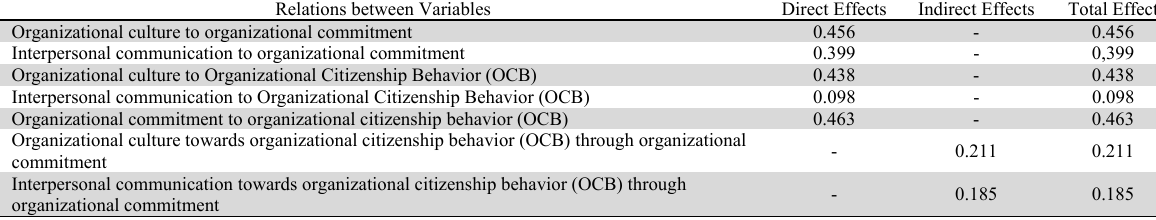
Direct Effects, Indirect and Total Influences Relations between Variables